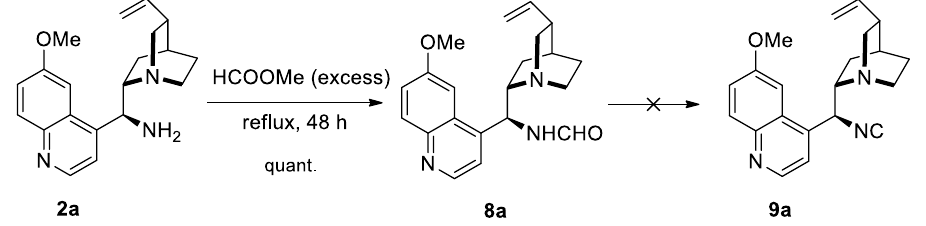
Scheme 3. Unsuccessful attempts to prepare isocyanide 9a